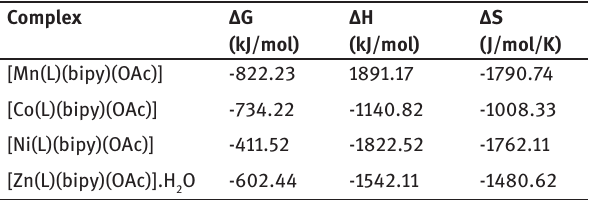
Table 2 : Thermodynamic parameters of metal complexes obtained at B3LYP/ 6-31+G(d,p) +LANL2DZ